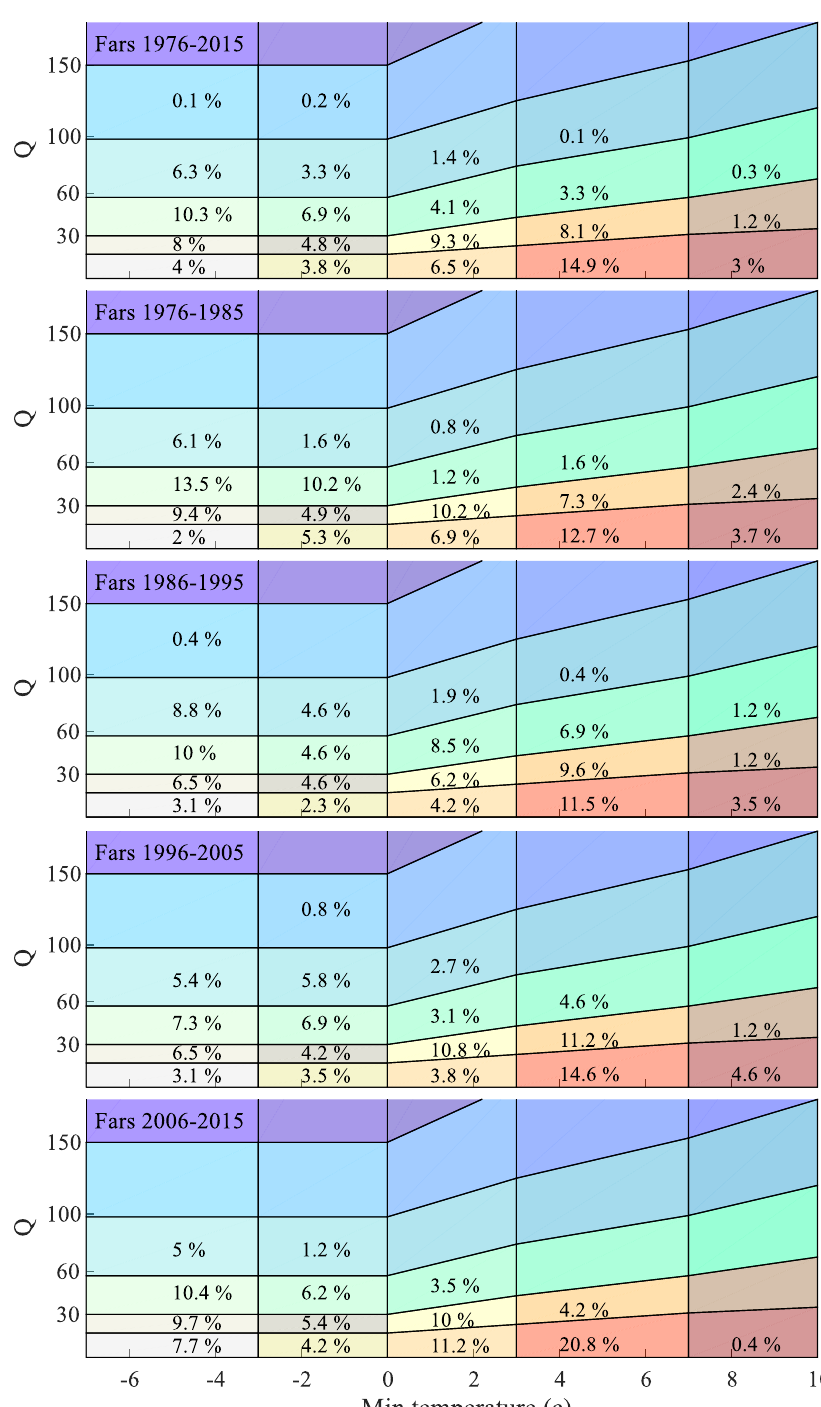
Figure A1. Distribution (percentage) of climate types in Fars province in different periods.